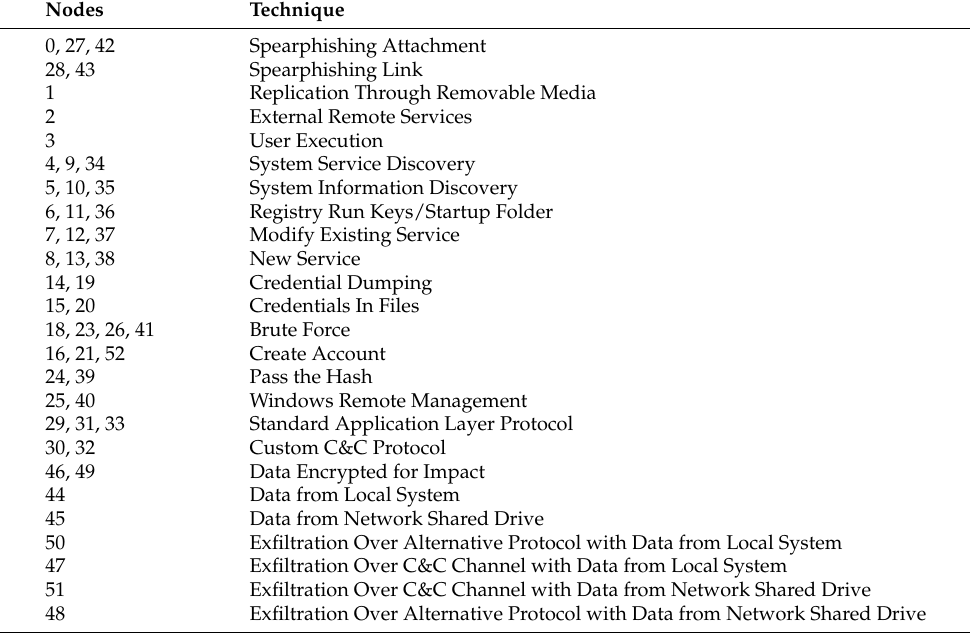
Table 4. Technique contained in each node of graph.